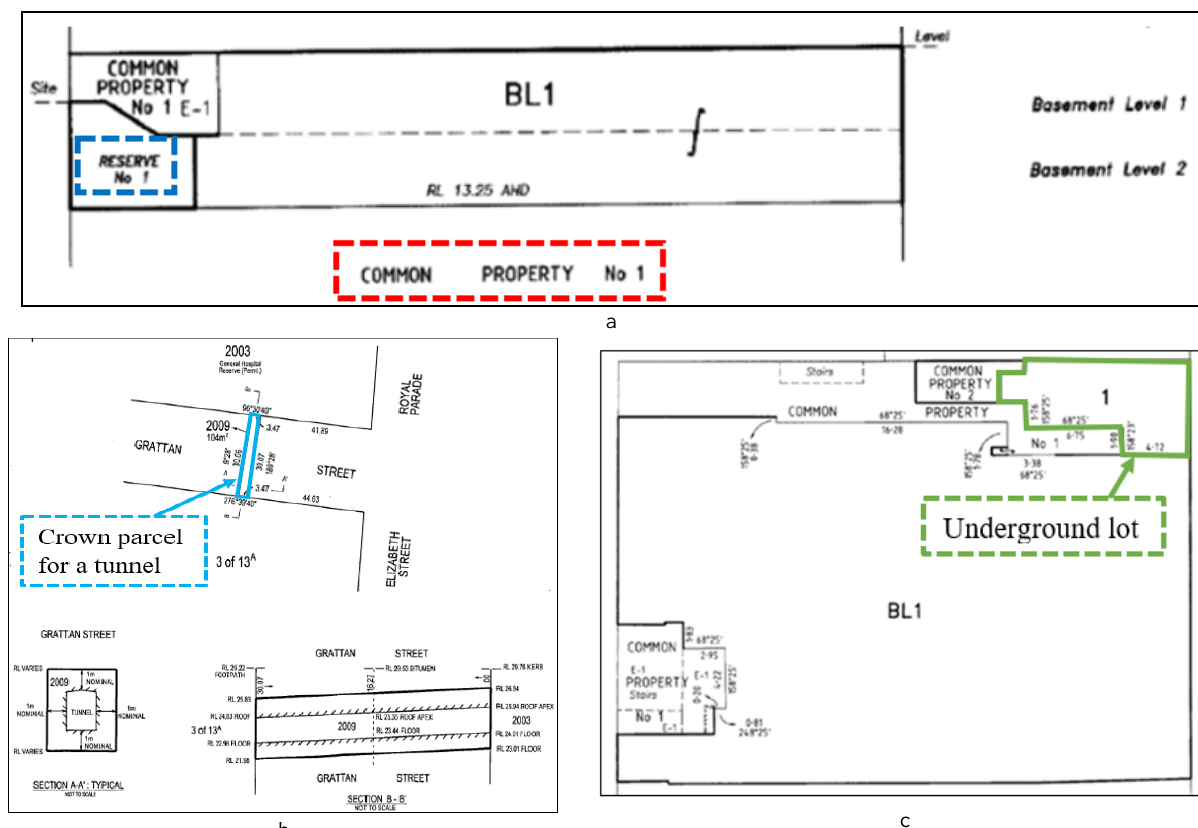
Figure 1 . Examples of underground primary parcels: a) common property and reserve; b) crown parcel; c) underground